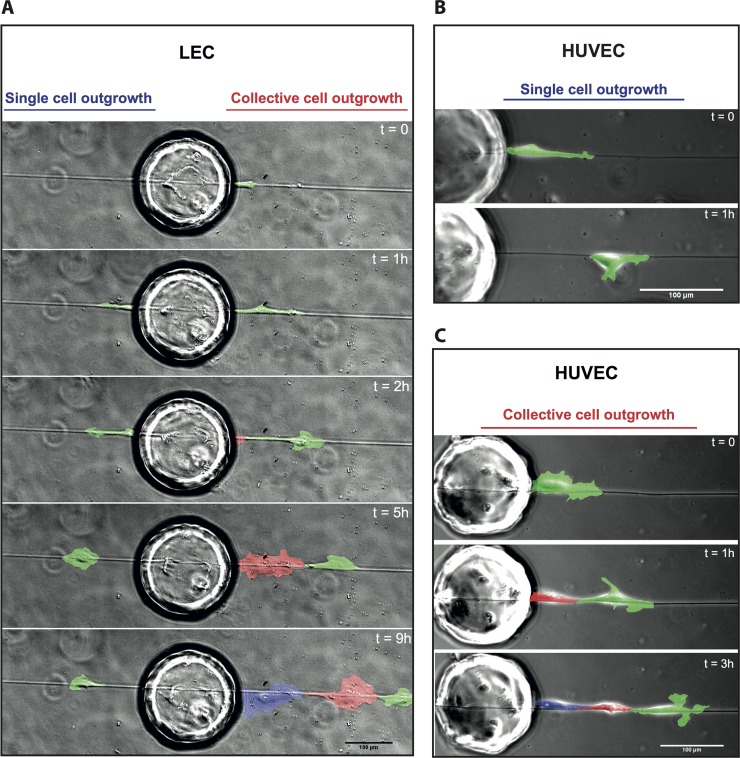
Outgrowth of LEC and HUVEC on Fn fibers is either single or collective.LEC (A) or HUVEC (B,C) coated beads incubated with Fn fibers for 6h and then observed by phase contrast video-lapse microscopy. t = 0 denotes the beginning of the first outgrowth event. (A) Time series showing two LEC events initiated from one bead (each cell pseudo-colored with a different color for clarity). Images temporally depict a single outgrowth event to the left of the bead and a collective event initiated by a leading cell to the right (also refer to S1 Video). (B) Time series showing one HUVEC single outgrowth event (pseudo-colored in green) from one bead (also refer to S2 Video). (C) Time series showing one HUVEC collective outgrowth event (each cell pseudo-colored with a different color for clarity) from another bead (also refer to S3 Video). Scale bar represents 100 μm.